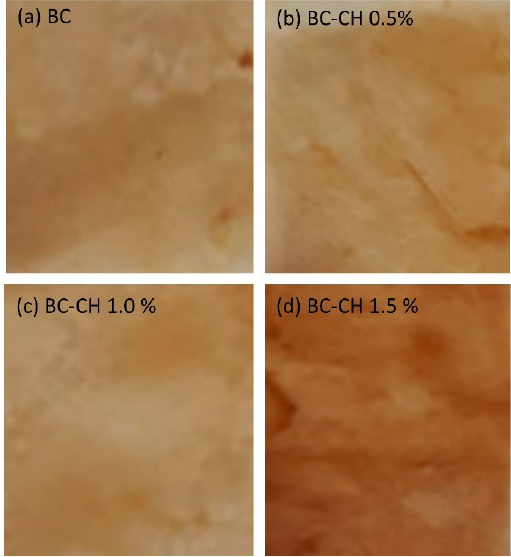
Figure 5. Color and opacity of: ( a ) BC, and ( b – d ) BC ‐ CH films coated with various concentrations of chitosan.